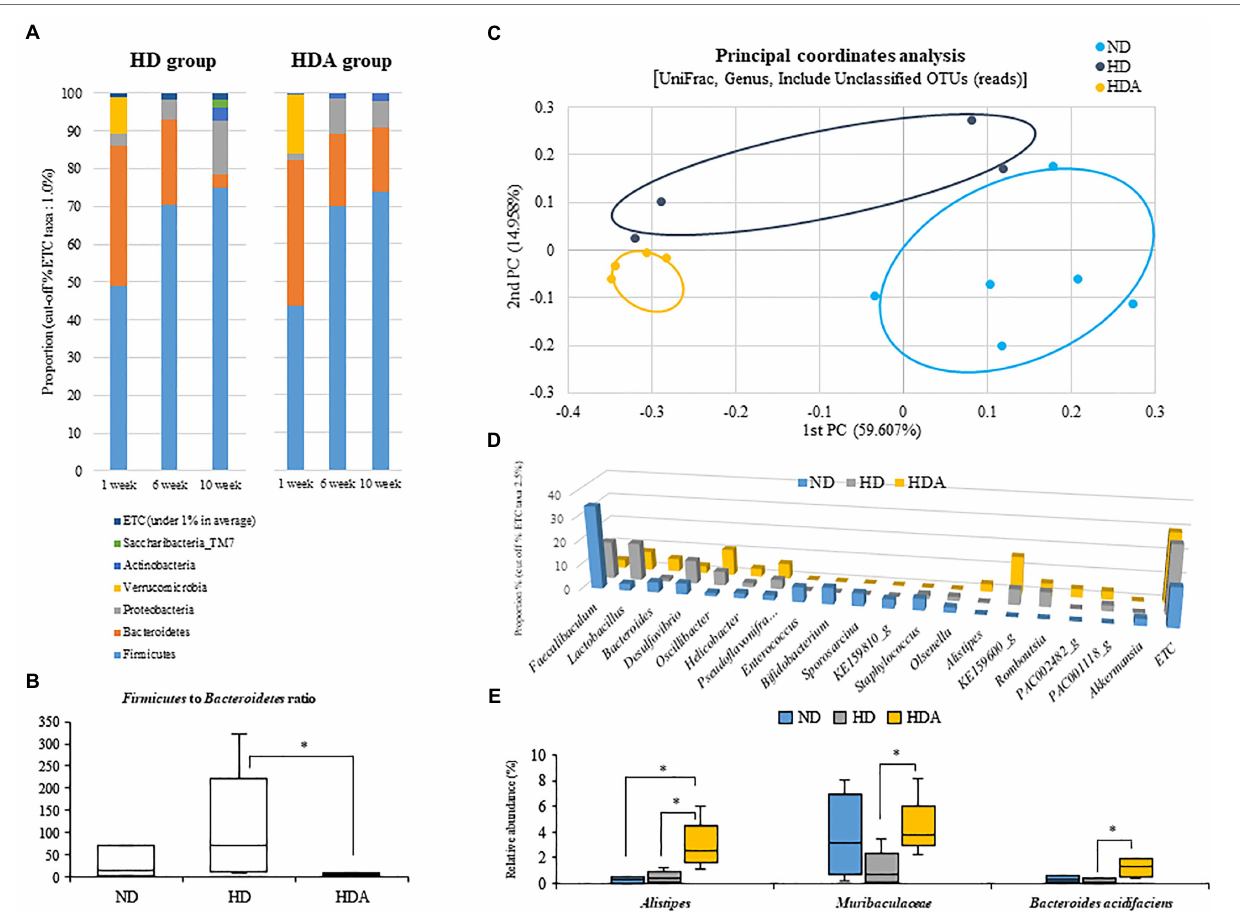
FIGURE 4 | Effect of administered L sakei ADM14 on fecal microbiome composition. (A) Changes in fecal microbiota in HD and HDA groups at the phylum level in 1, 6, and 10 weeks. (B) Firmicutes to Bacteroidetes ratios between groups at 10 weeks. (C) Fecal microbiota composition of groups at 10 weeks is shown by the genus level UniFrac principal coordinates analysis (PCoA). (D) Main fecal microbiota composition of genus level (cut off taxa 2.5%) at 10 weeks. (E) The relative abundance of specific taxa in fecal microbiota at 10 weeks. The results are shown as mean ± SEM ( n = 4–6). Significant differences between groups are indicated as * p <